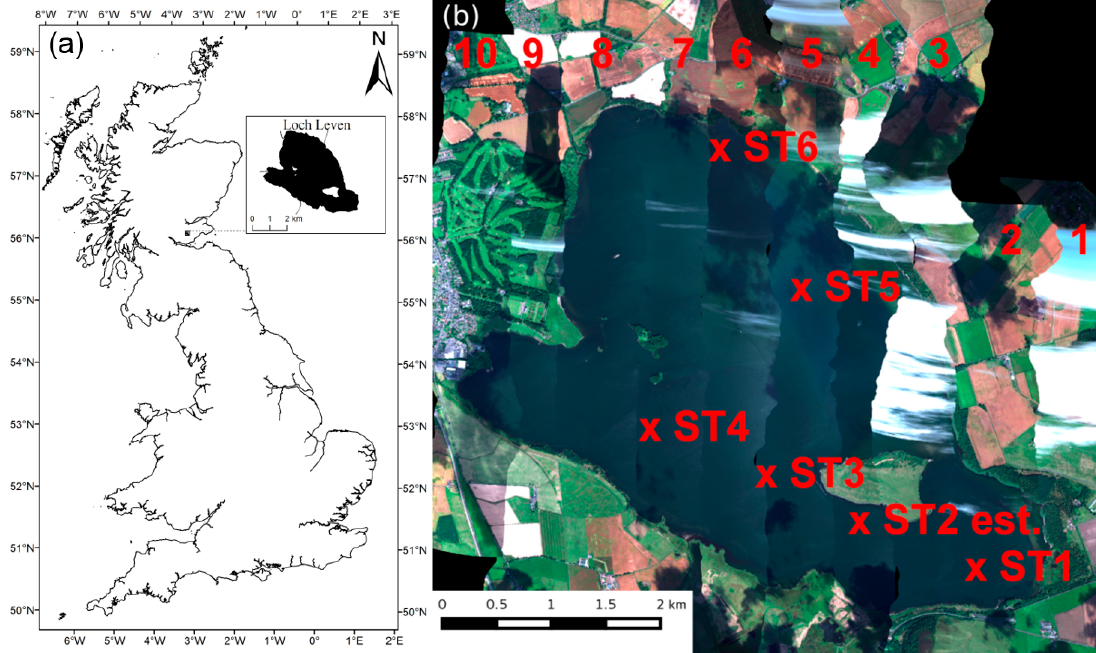
Figure 1. ( a ) map showing the location of Loch Leven within the UK; ( b ) Image mosaic from 10 FENIX flight lines collected during the campaign (colours are illustrative only). Locations of the in situ station measurements are marked with red crosses; the location of station ST2 is approximate.